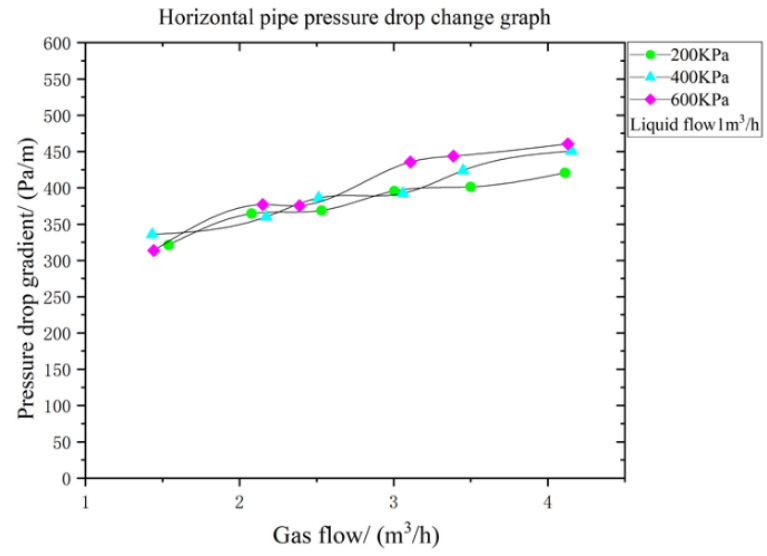
Figure 14. Pressure gradient diagram under different pressures and gas flows.